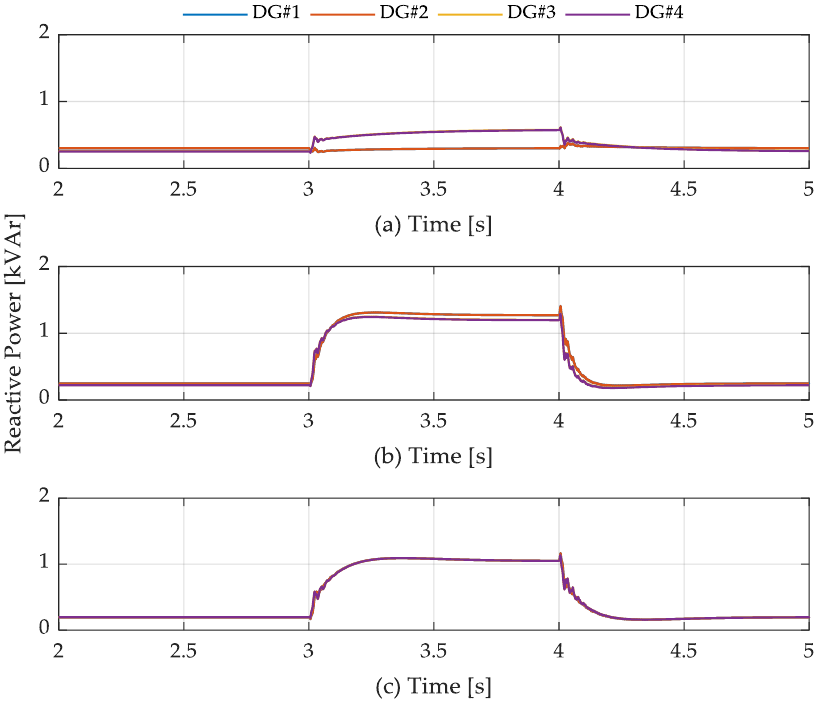
Figure 8. Output reactive power of each DG: ( a ) without LVRT; ( b ) centralized method; ( c ) proposed method.